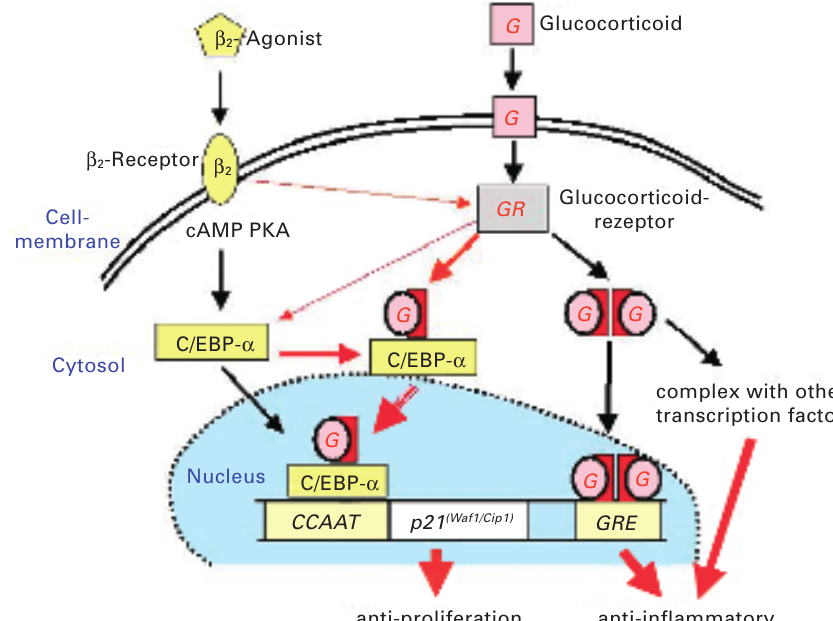
Figure 2 The interaction of the glucocorticoid and b 2 -agonist signalling pathway and its conse- quences for the anti-inflammatory and the anti-proliferative effect of the two drugs. As C/EBP- a is missing in airway smooth muscle cells of asthma patients, the anti-proliferative effect of especially glucocorticoids cannot be effective. However, the anti-inflammatory action of glucocorticoids, mediated via the glucocorticoid receptor dimer and the GRE- promoter element as well as via the interaction of the GR with other transcription factors, is fully functional.